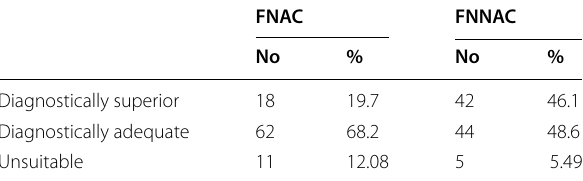
Table 14 Comparison between FNAC and FNNAC